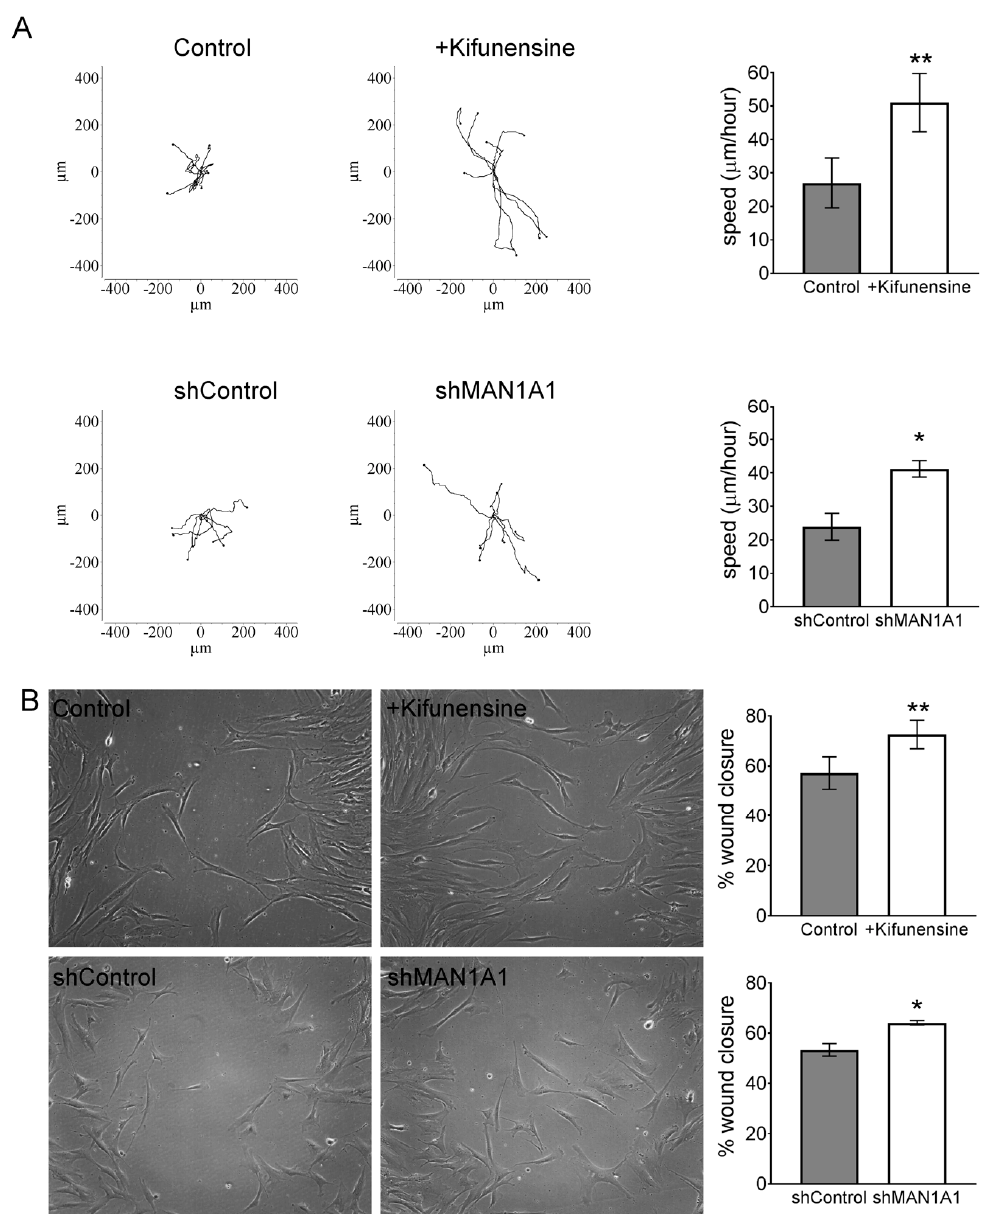
Figure 1. Inducing high mannose N-glycans increases the migration potential of mesenchymal stromal cells (MSCs) ( A ) Cell tracking after videomicroscopy. Trajectories of representative cells over 20 h are shown and quantified on bar graphs on the left ( n = 3 for experiment with Kifunensine and n = 6 for experiment with shMAN1A1). ( B ) Wound/scratch assays. Representative images of wound closure after 24 h are shown, with quantification on bar graphs on right ( n = 4 for experiment with Kifunensine and n = 5 for experiment with shMAN1A1). * p < 0.05 and ** p < 0.005.